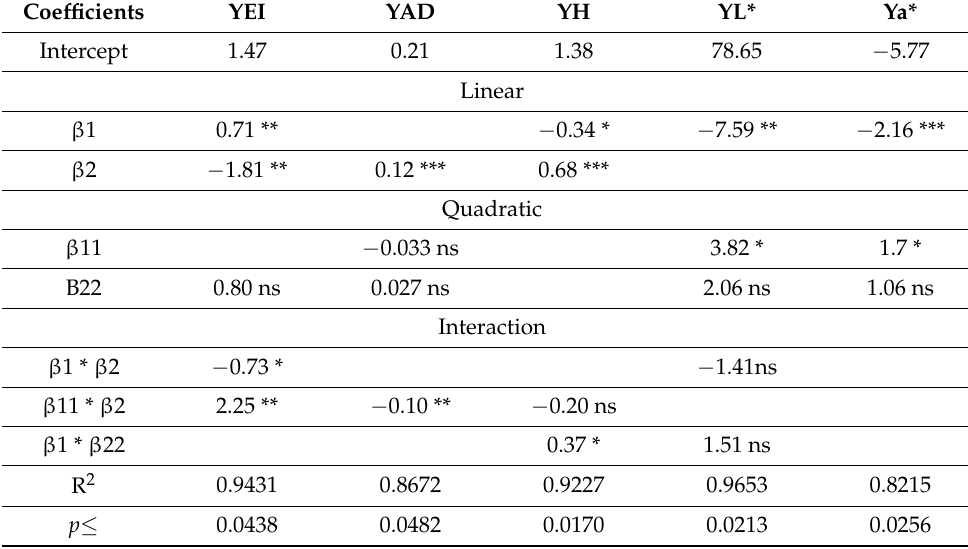
Table 6. Regression analysis values of snacks made with native starch (Design-Expert 7.0.0). Coefficients